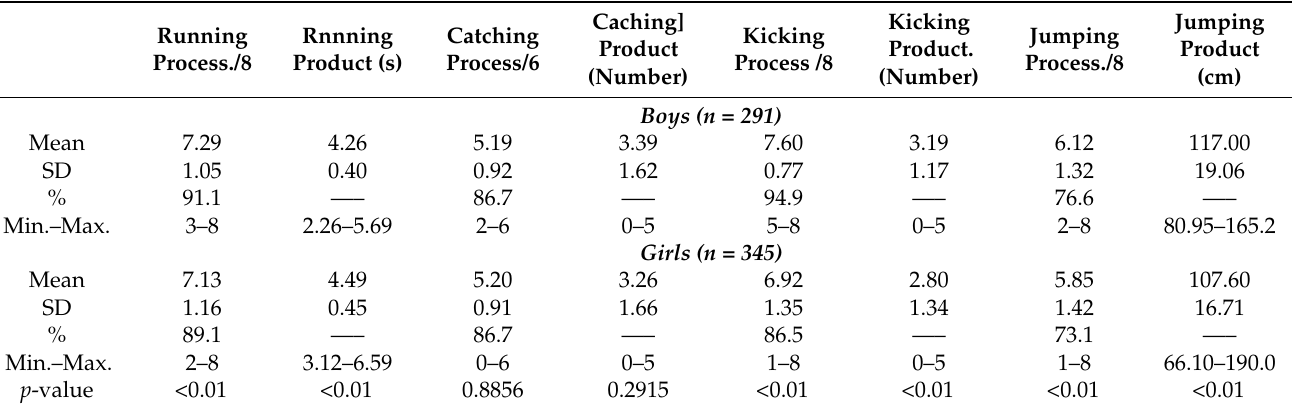
Table 2. Process and Product FMS Performance differences in the group of five- to eight-year-olds, by sex.